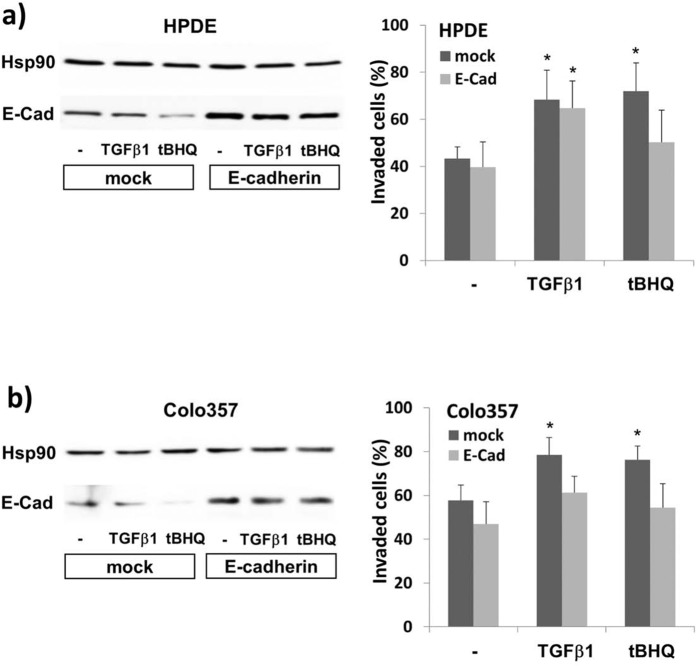
Maintained expression of E-cadherin affects the inducing effect of Nrf2 activation on the invasion of premalignant and malignant pancreatic duct cells.HPDE (A) or Colo357 (B) cells were transfected with a constitutive E-cadherin expression vector or an empty pcDNA3.1 vector (mock). Afterwards, cells were incubated with 50 μM tBHQ or 10 ng/mL TGF-β1 for 24h, or were left untreated. Then, cells were submitted to the modified Boyden assay on collagen-I coated transwells (A,B, right panels). In parallel, total cell lysates were analysed by E-cadherin western blots (A,B, left panels) using Hsp90 as loading control. A densitometric band intensity evaluation is provided in Figs. A and B in S7 File. The westernblots show representative results from four independent experiments. The invasion data (A,B, right panels) represent the mean ± SD of four independent experiments performed in duplicate, *p<0.05 (treated versus untreated).